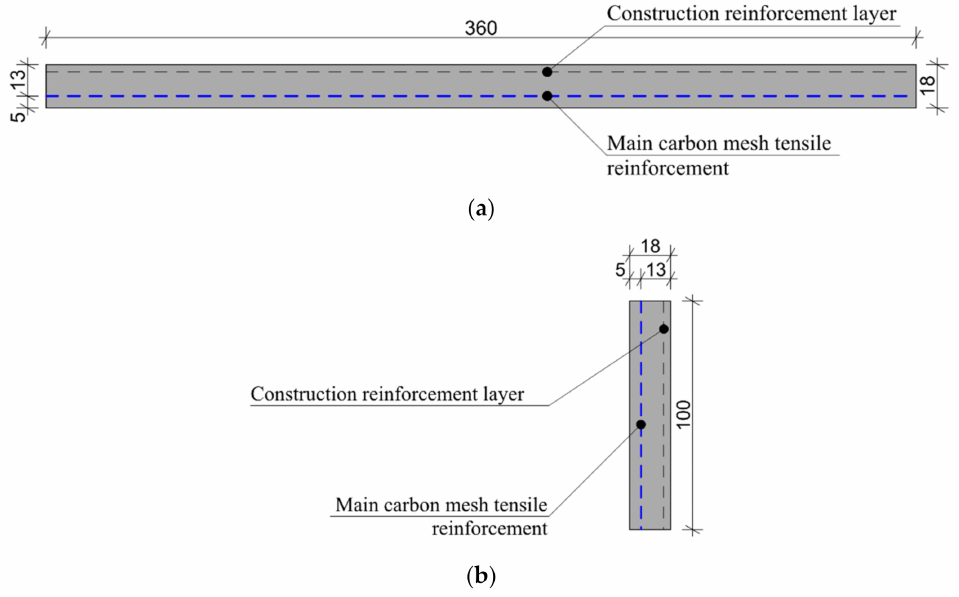
Figure 5. Description of the experimental sample and position of reinforcement mesh (unit: mm): ( a ) Plan view of the experimental sample; ( b ) Cross-section of the experimental sample.